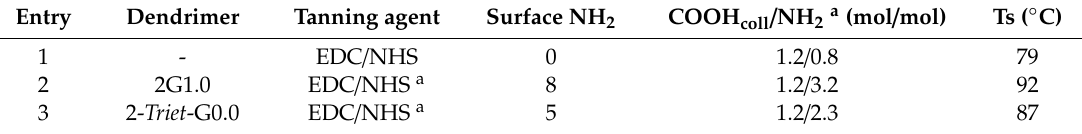
Table 3. E ff ect of PAMAM auxiliaries on the Ts of bovine hides cross-linked with EDC /